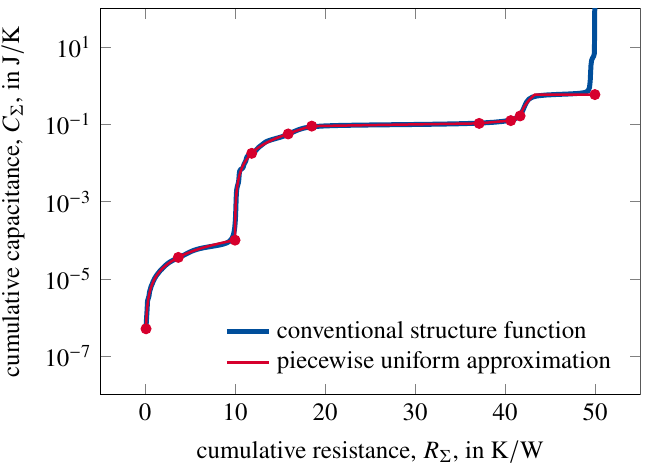
Figure 1. Conventional structure function and piecewise uniform approximation with ten sections. The divergence at the end is truncated in the optimization as it is a numerical